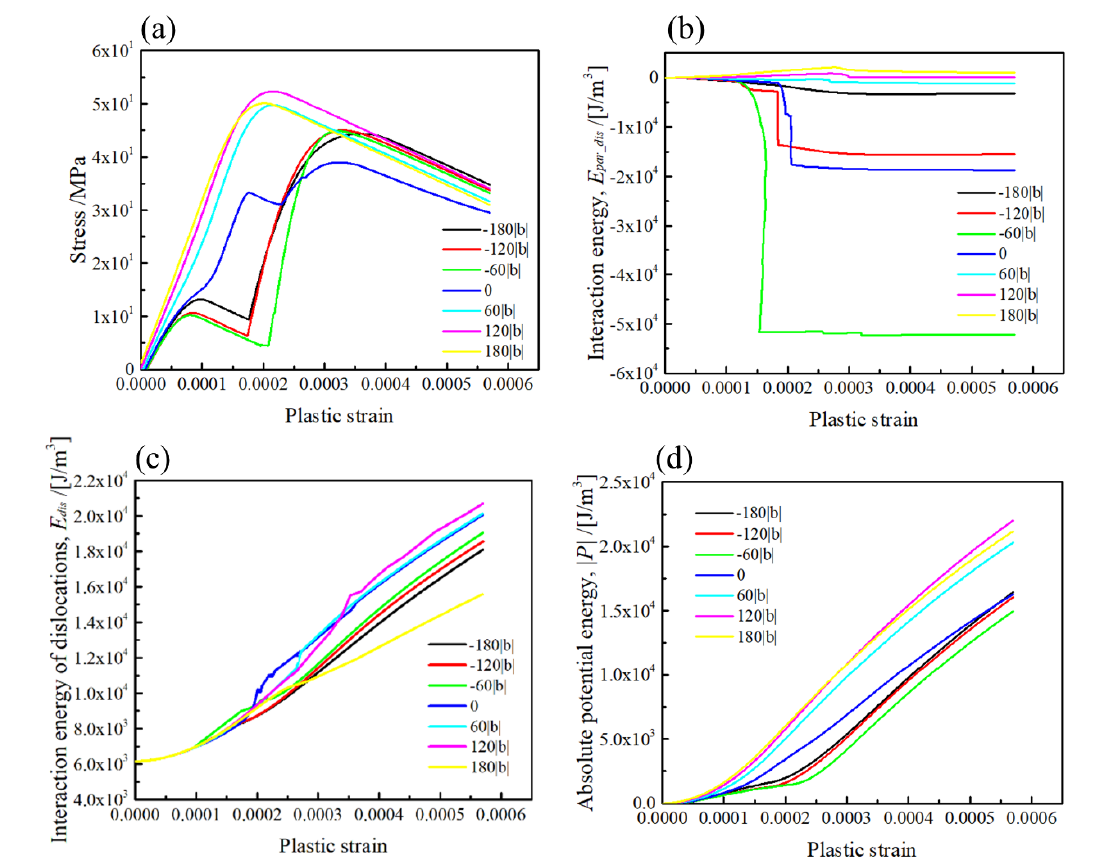
Figure 8. The geometrical effect on the misfit hardening by the [010] rod precipitate. ( a ) Stress– strain curve, ( b ) interaction energy of the precipitate and dislocation, ( c ) interaction energy of the dislocations, ( d ) potential energy due to the dislocation motion. The relative position of the (111) slip plane is ranging from z/|b| = − 180 to